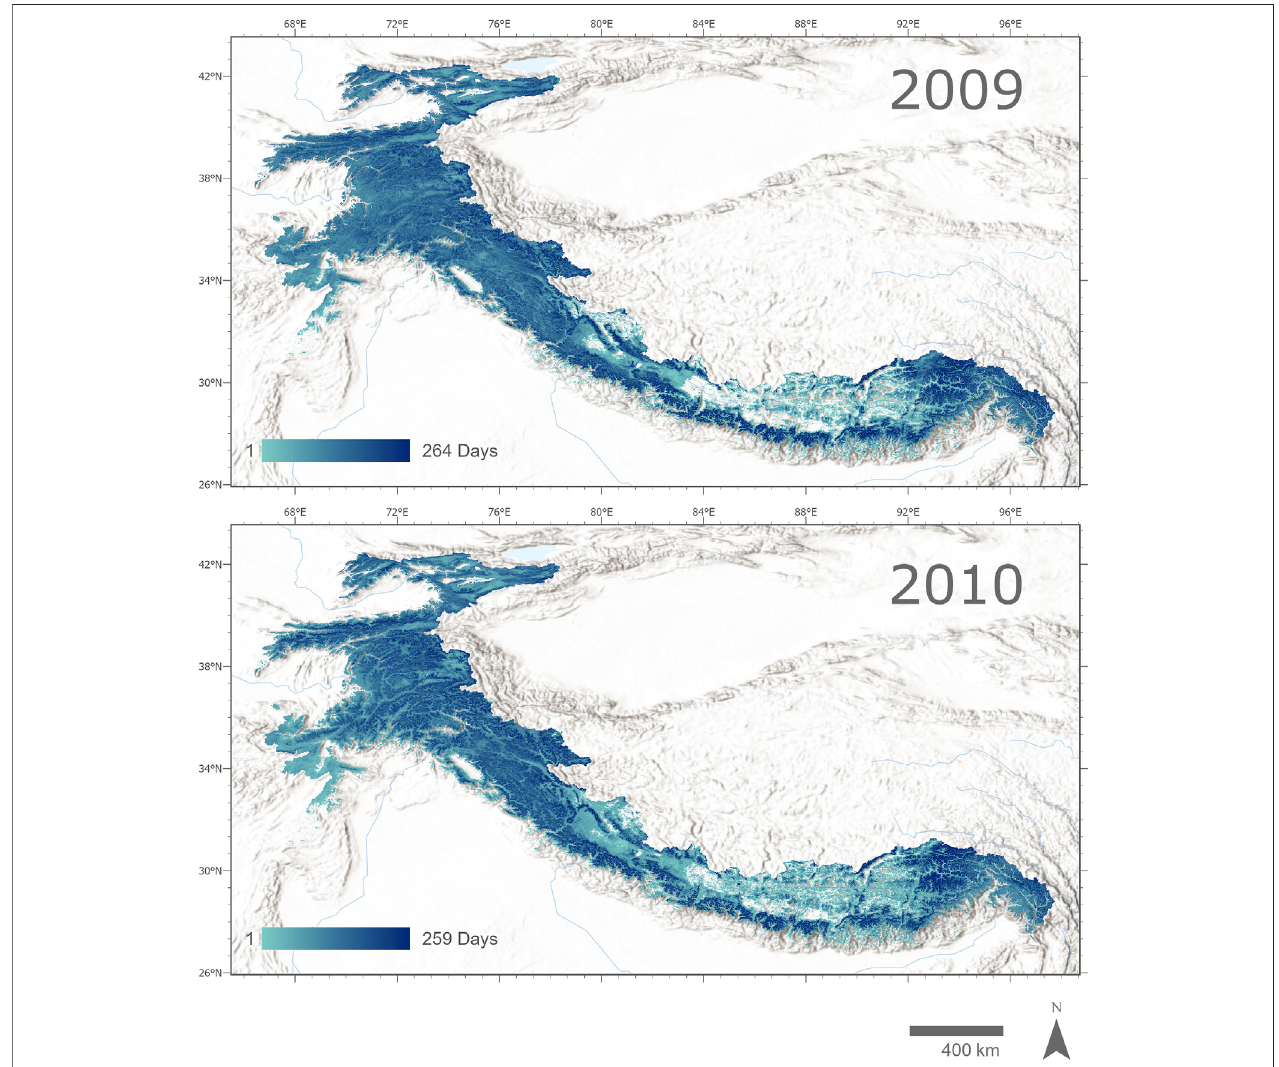
FIGURE 5 | Difference maps between fSCD and SCD across the full study area in 2009, when snow cover duration was relatively high (118 fSCD) and in 2010, whensnowcoverdurationwasrelativelylow(83fSCD).ThedarkbluepixelsindicateareaswherethelargestdifferencesarehighlightingwherebinarySCDoverestimates snow cover relative to